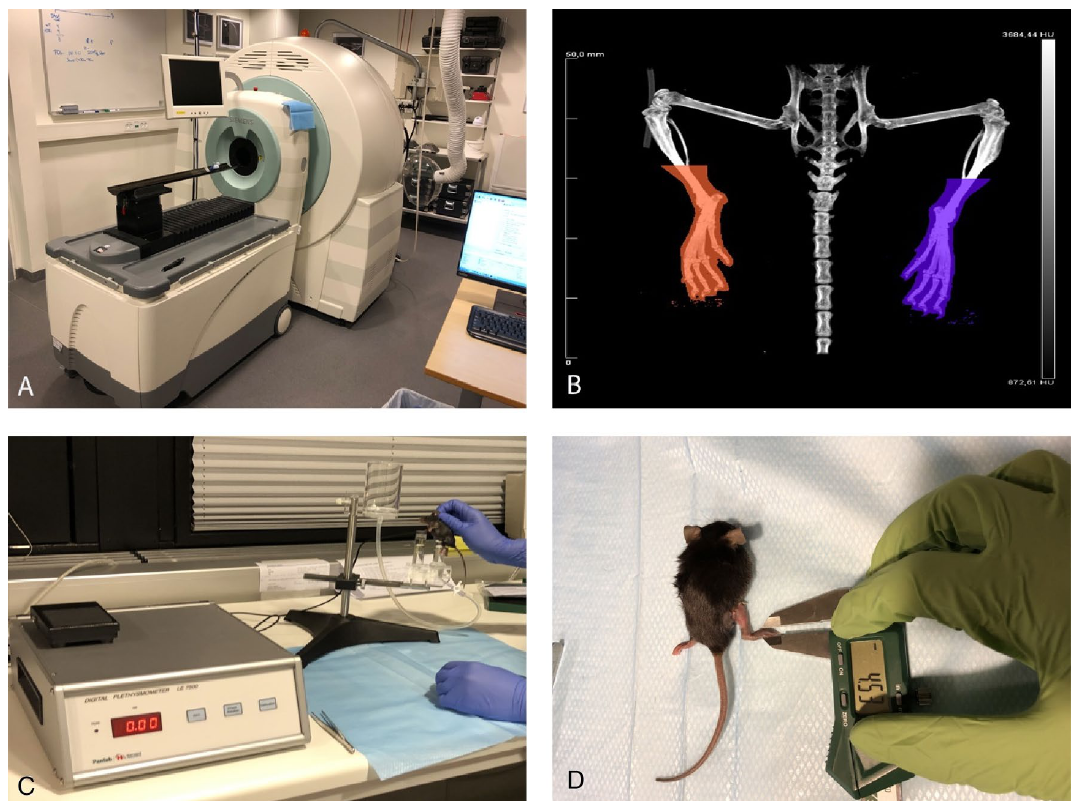
Figure 8. Overview of the modalities. ( A ) μ-CT scanner, ( B ) μ-CT scan showing the volumetric measures of both hindlimbs, ( C ) Plethysmometer measurement showing the inserting of the right lymphedema hindlimb, ( D ) Electronic caliper measurement of right lymphedema hindlimb paw. CT computed tomography, μ